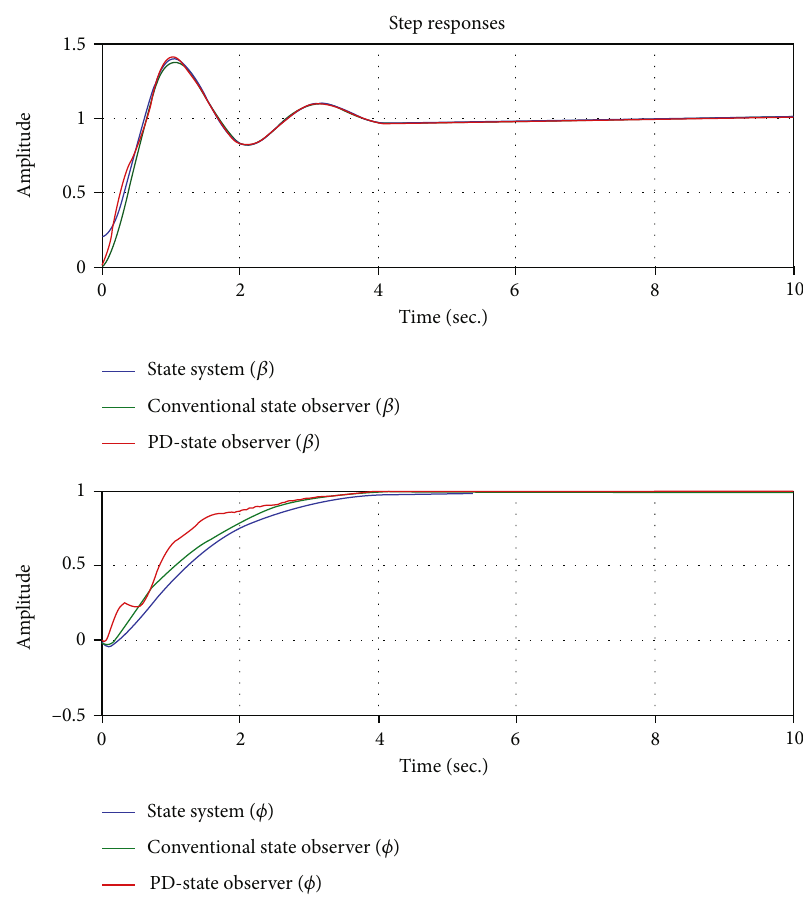
β = 0 : 1 I 2×2 2×2